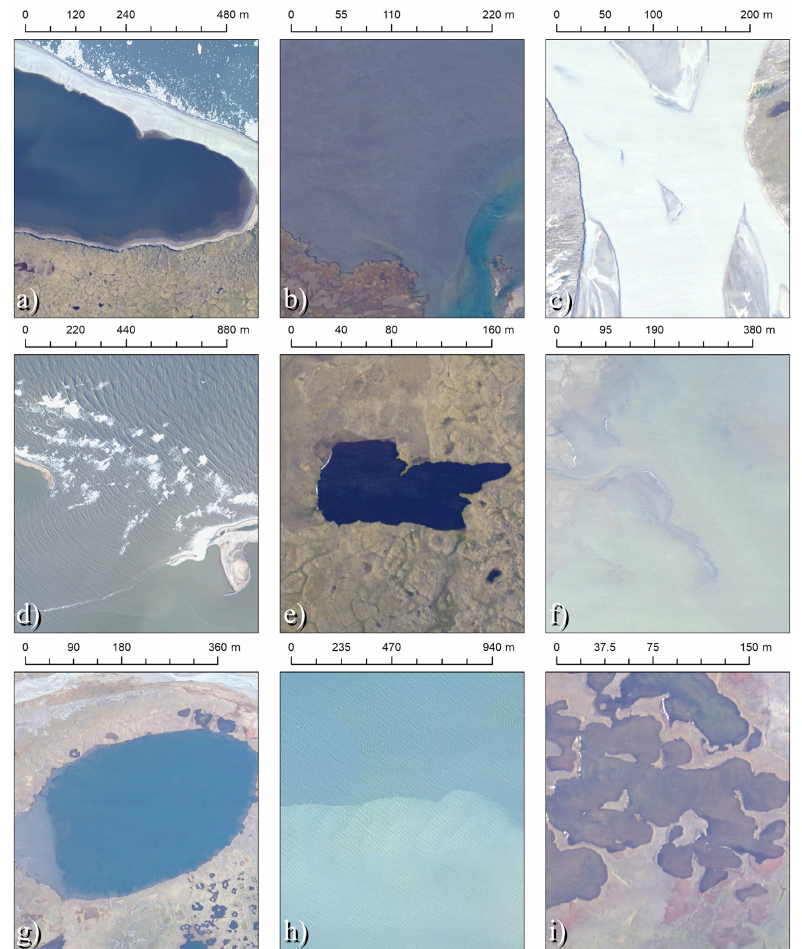
Figure 3. Natural color (RGB) image tiles selected from 2017 NOAA airborne imagery taken over the study area displaying the spectral variability of coastal and surface water bodies: ( a ) lagoonal waters bound by tundra and a sand spit; ( b ) dark, turbid coastal waters near the mouth of a river; ( c ) waters of a braided river carrying highly reflective glacial-derived sediments from the Brooks Range to the south of the study area; ( d ) coastal waters breaking near barrier islands; ( e ) dark and deep waters of a tundra pond; ( f ) shallow and turbid waters near a deltaic region; ( g ) blue waters of a large thermokarst lake; ( h ) sediment dispersion from coastal erosion in the nearshore; ( i ) shallow waters of a coalesced low-center polygonal